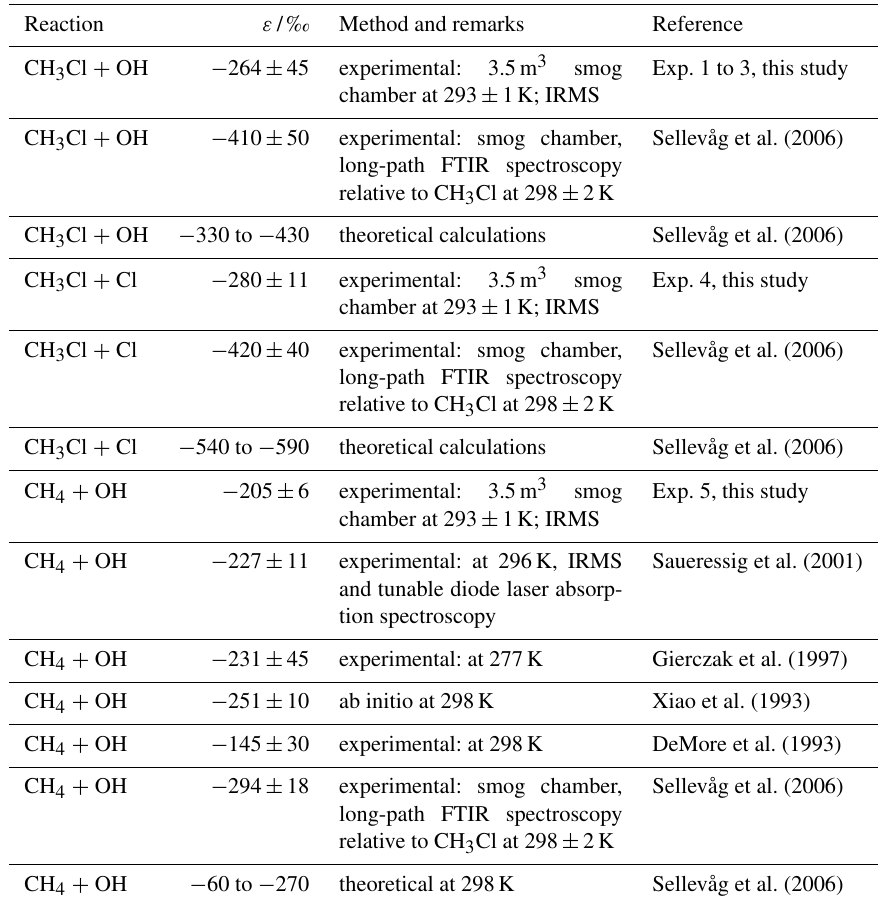
Table 1. Reported hydrogen isotope enrichment constants for the reaction of CH 3 Cl with OH radicals and with Cl atoms and the reaction of CH 4 with OH radicals. Reaction ε /‰ Method and remarks Reference CH 3 Cl + OH − 264 ± 45 experimental: 3.5m 3 smog Exp. 1 to 3, this study chamber at 293 ± 1K; IRMS Sellevåg et al. (2006) CH 3 Cl + OH − 410 ± 50 experimental: smog chamber, long-path FTIR spectroscopy relative to CH 3 Cl at 298 ± 2K CH 3 Cl + OH − 330 to − 430 theoretical calculations Sellevåg et al. (2006) CH 3 Cl + Cl − 280 ± 11 experimental: 3.5m 3 smog Exp. 4, this study chamber at 293 ± 1K; IRMS Sellevåg et al. (2006) CH 3 Cl + Cl − 420 ± 40 experimental: smog chamber, long-path FTIR spectroscopy relative to CH 3 Cl at 298 ± 2K CH 3 Cl + Cl − 540 to − 590 theoretical calculations Sellevåg et al. (2006) CH 4 + OH − 205 ± 6 experimental: 3.5m 3 smog Exp. 5, this study chamber at 293 ± 1K; IRMS − 227 ± 11 experimental: at 296K, IRMS Saueressig et al. (2001) and tunable diode laser absorp- tion spectroscopy experimental: at 277K Gierczak et al. (1997) ab initio at 298K Xiao et al. (1993) experimental: at 298K DeMore et al. (1993) experimental: smog chamber, Sellevåg et al. (2006) long-path FTIR spectroscopy relative to CH 3 Cl at 298 ± 2K − 60 to − 270 theoretical at